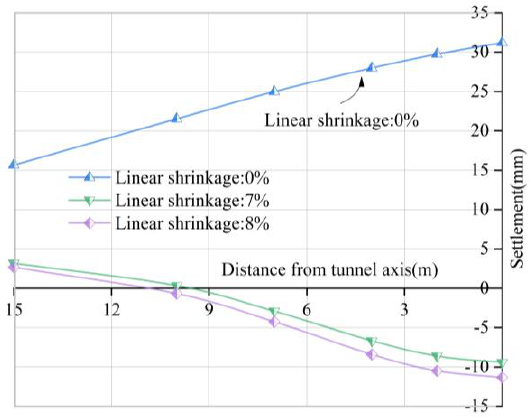
Figure 11. Influence of linear shrinkage rate on the lateral deformation of the ground surface.